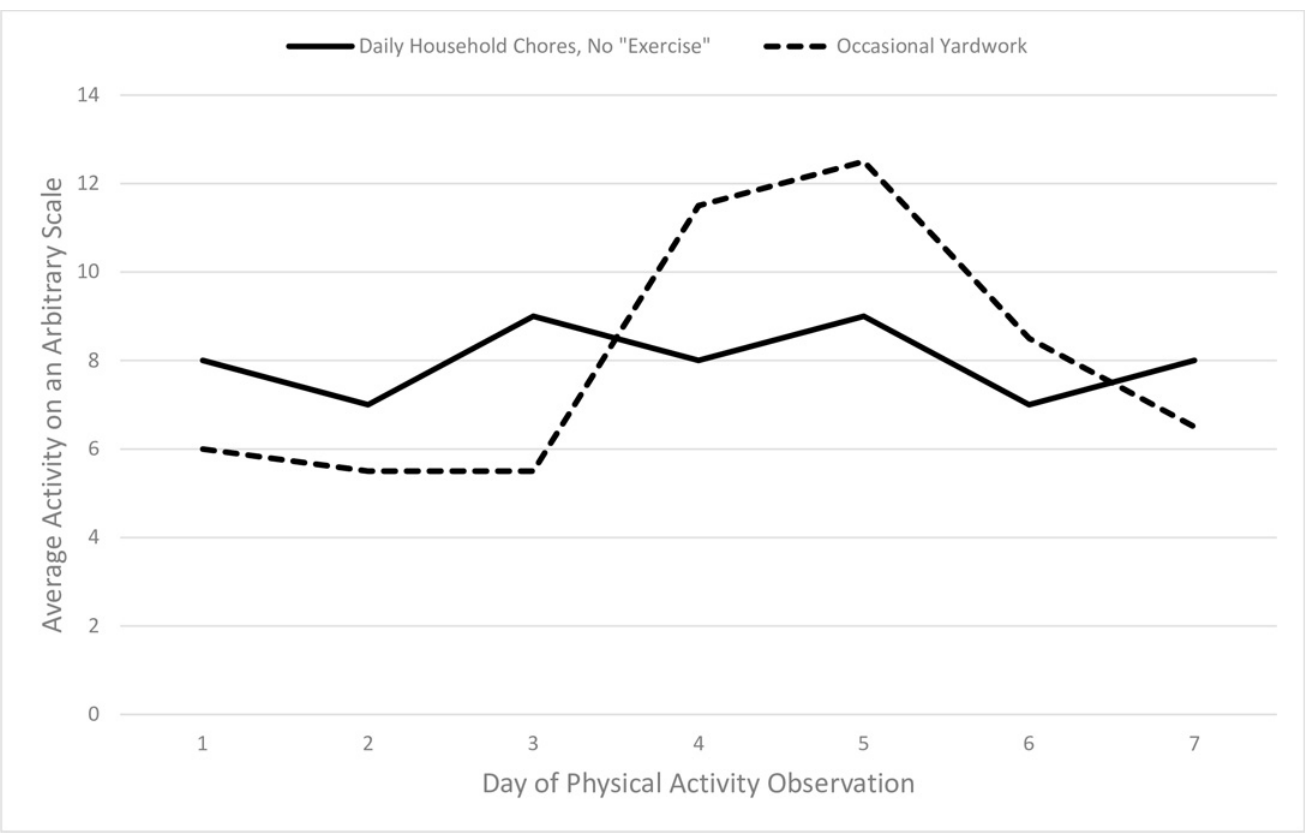
Fig 1. Example Activity Patterns with Same Means and Different Variability Patterns. The solid line represents example pattern 1) a retired person who does housework on most days, but who never engages in structured exercise. The dashed line represents example pattern 2) an older person who spends most of the day using the computer, but has bouts of vigorous outdoor gardening and home repairs when the weather allows.